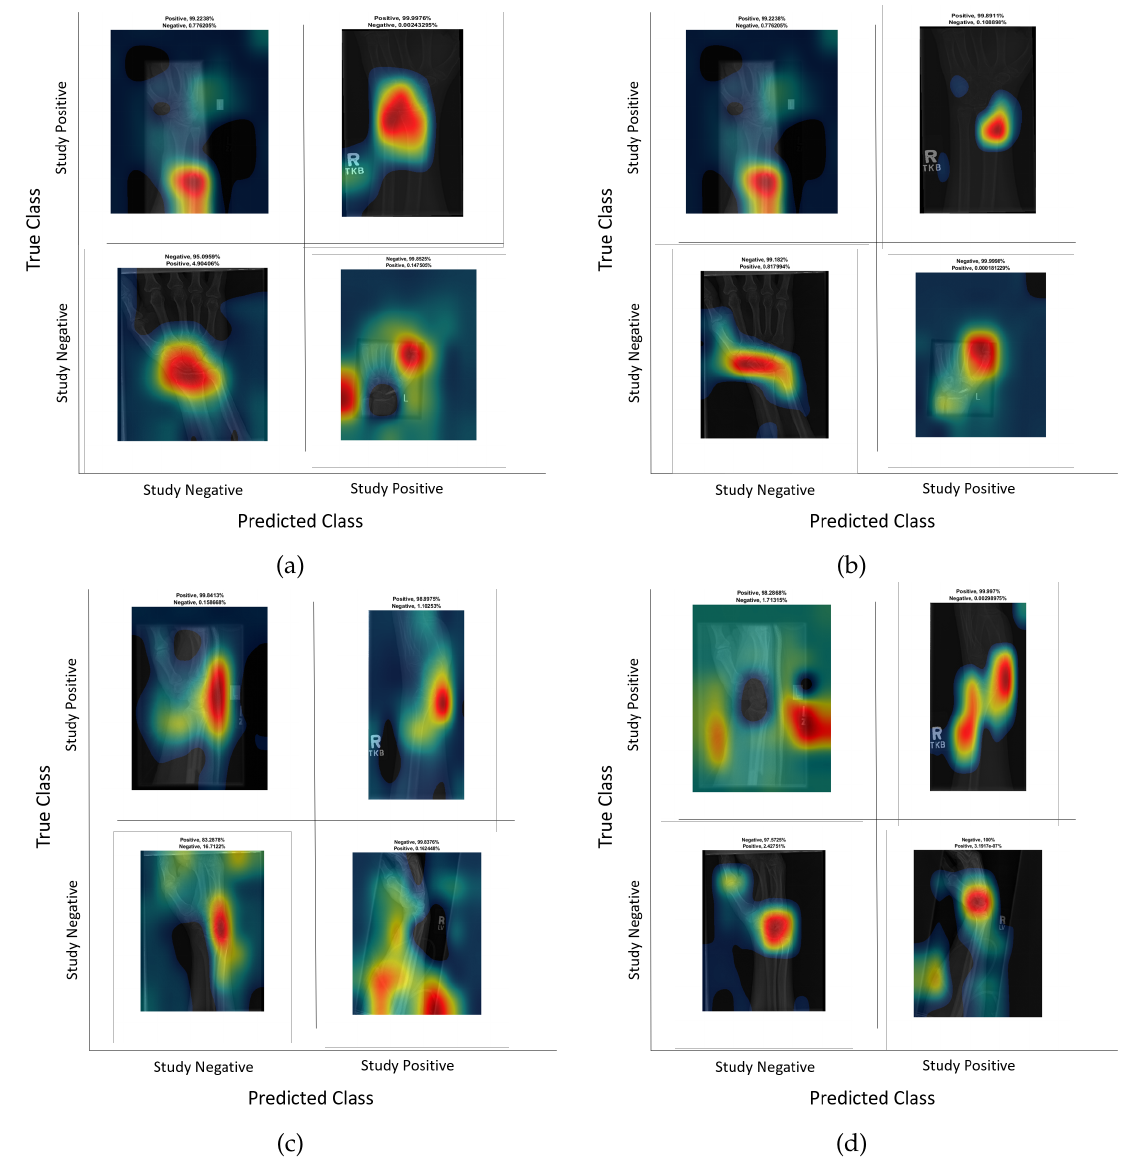
Figure 11. Illustration of the class Activation Maps overlaid on the four classification results for ( a , b ) Postero-anterior and ( c , d ) Lateral views shown in Figures 5 and 6 for ResNet 50 ( a,c ) and Inception-ResNet-v2 ( b,d ). In general Inception-Resnet- v2 presented more focused and smaller activation maps. It should also be noted that whilst for correct classifications, the highlighted regions are similar, for some incorrect classifications ( c,d , top left and bottom right) the activations are quite different, which suggest that the architectures may not be confusing salient regions that are not related with the condition of normal or